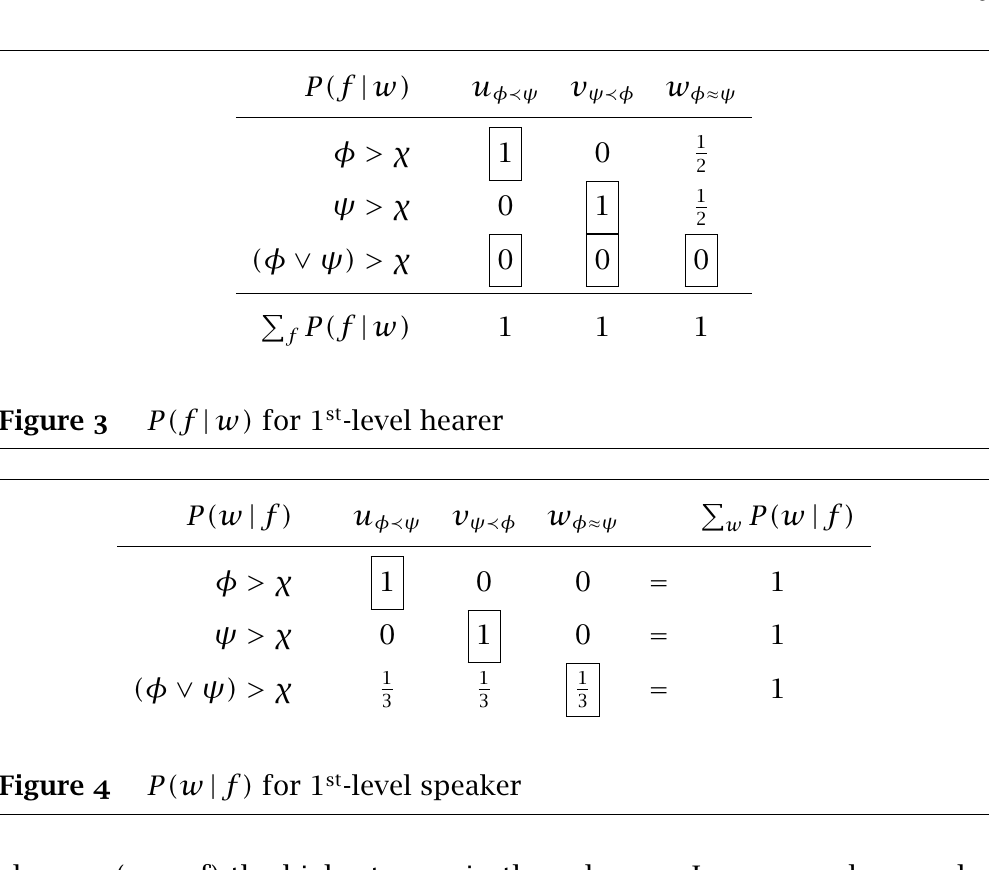
and v she φ ≺ ψ ψ ≺ φ she now chooses (φ ∨ ψ) > χ instead φ ≈ ψ